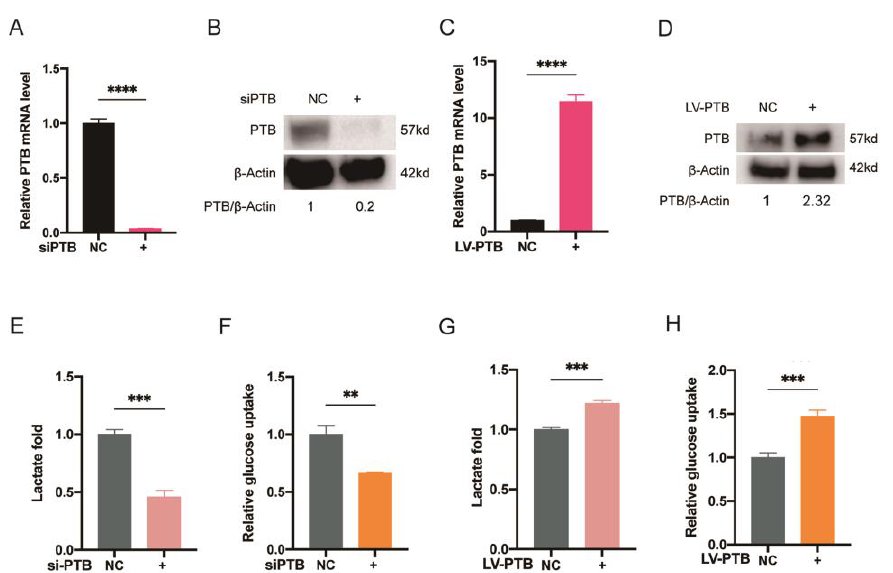
Figure 2. PTB promotes glycolysis flux in KFb. ( A , B ) The knockdown of PTB in KFb was measured by qRT-PCR and Western blotting. ( C , D ) Overexpression of PTB in NFb was measured by qRT-PCR and Western blotting. Lactate production ( E ) and glucose uptake ( F ) were measured in the KFb transfected with si-PTB. Lactate production ( G ) and glucose uptake ( H ) were measured in the NFb transfected with the PTB lentivirus vector. ( n = 3). ** p < 0.01, *** p < 0.001, **** p < 0.0001.